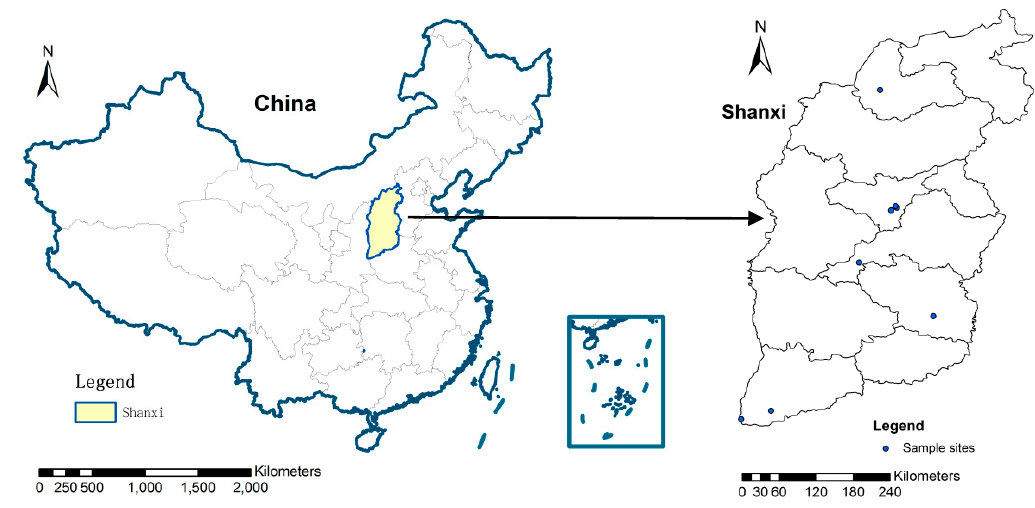
Figure 1. Sampling sites of wastewater treatment plants (WWPTs) locations in Shanxi Province, China.